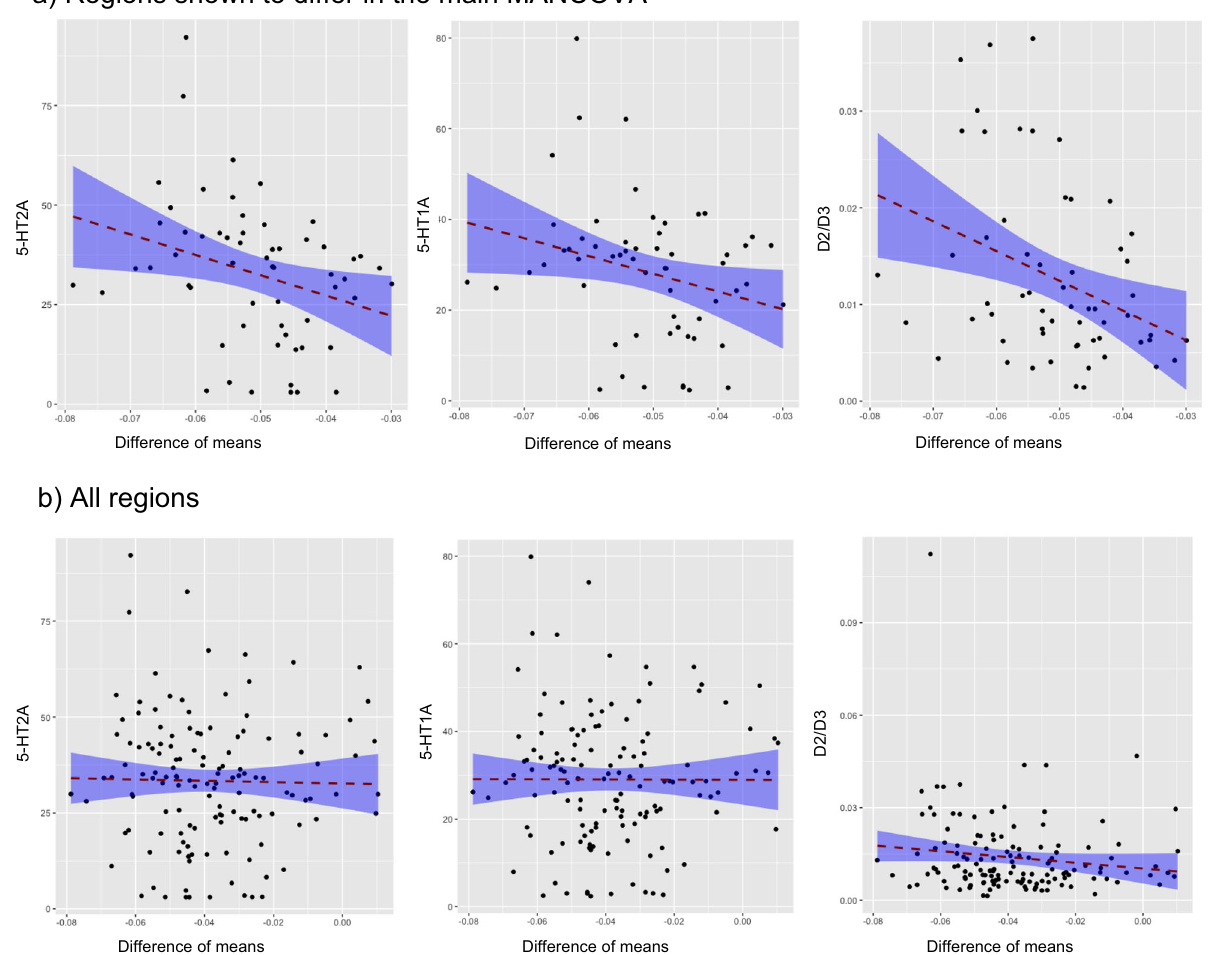
Fig. 3 Receptors density pro fi les: Results of regression models. Shown are the results of the linear regression (two-sided) models with receptor density as predictor and difference of the means (with hallucinations – without) of cortical thickness as dependent variable. a Regions which were different between groups as dependent variable and b the models for all regions. Results are reported for 5-HT2 A , 5-HT1 A , and D2/D3 receptors binding potential and cortical thickness, further details are in S6. In addition, the p value of the correlation between thickness and each receptor map taking into account spatial autocorrelation is reported in the text. The shaded area represents the con fi dence